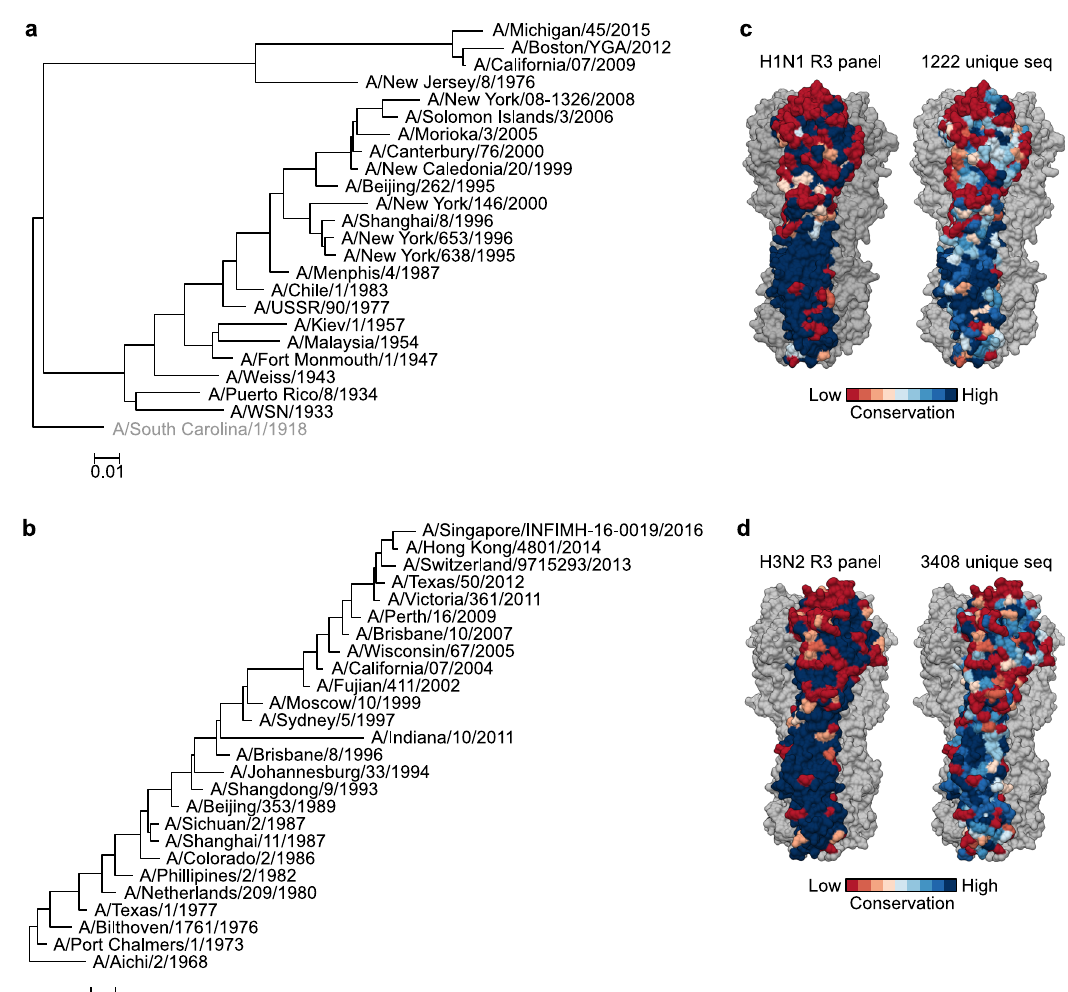
Fig. 3 Phylogenetic and protein surface conservation analysis of HA of H1N1 and H3N2 viruses used in the study. a , b Phylogenetic tree of 24 H1 ( a ) and 26 H3 ( b ) HA sequences used in the R3 panel. The tree was generated by NJ method and rooted with A/South Carolina/1/1918 ( a ) (not used in the study) or with A/Aichi/2/1968 ( b ). Distance scale bar indicates 1% difference in nucleotide identity. c , d Protein surface conservation of H1 ( c ) and H3 ( d ) HA used in the R3 panel and a larger non-redundant representative dataset. Amino acid conservation at each residue was calculated and scored by using the Consurf server (https://consurf.tau.ac.il/) and rendered on the structure of A/California/07/2009 (PDB: 3LZG) ( c ) and A/Victoria/361/2011 (PDB:4WE8) ( d ). Conservation at each position was scored 1 – 9 (lowest to highest) and colored according to the conservation score on one protomer of HA trimer. Two other HA protomers are colored in